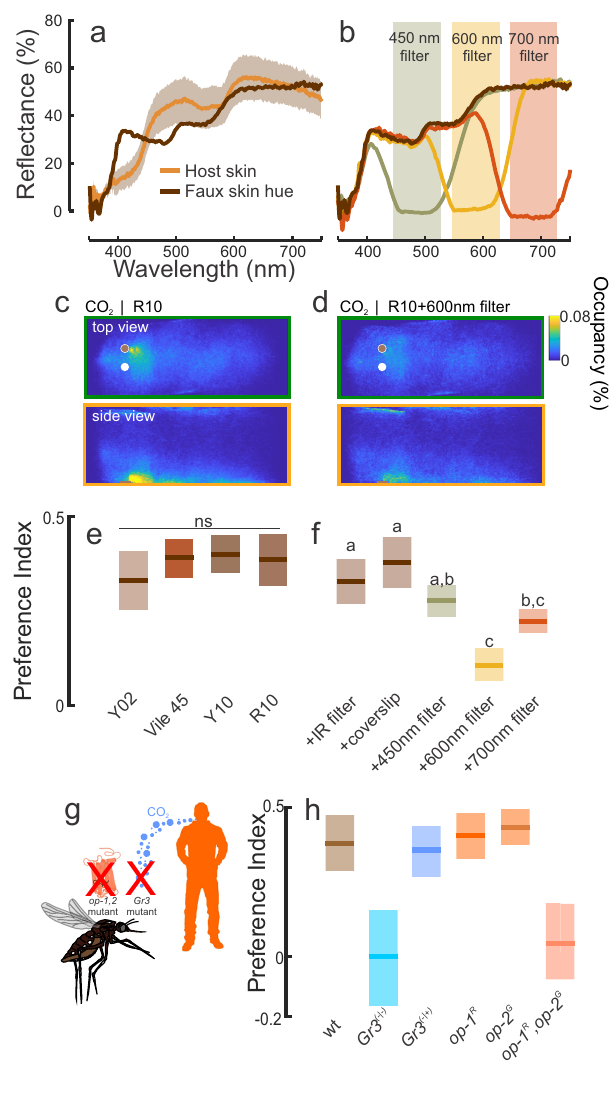
Kruskal – Wallis test: df = 2, Chi-square = 84.04, P < 0.001). Mos- quitoes showed no preference during control experiments with two white gloves displayed in the window, but signi fi cantly preferred skin (Fig. 3f; Kruskal – Wallis test with multiple comparisons: window, blocking the longer wavelengths (550 – 700 nm), the attraction was signi fi cantly reduced (Kruskal – Wallis test with multiple comparisons: P < 0.001) and not signi fi cantly different from the negative control (Fig. 3f; Kruskal – Wallis test with multiple comparisons: P = 0.34). Collectively, these results demonstrate that the long-wavelength band of the visual spectrum plays an important role in determining mosquito attraction to skin color. In addition, knockout of either visual or olfactory detection receptors suppresses mosquito visual attraction to long-wavelength host cues.